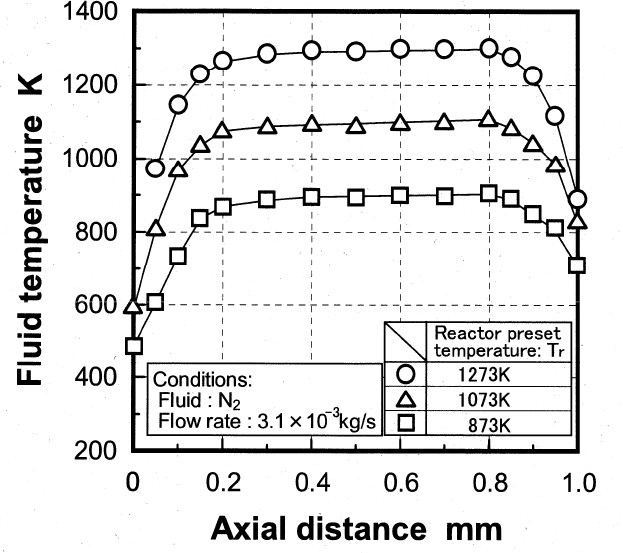
gas at rated condition. 2